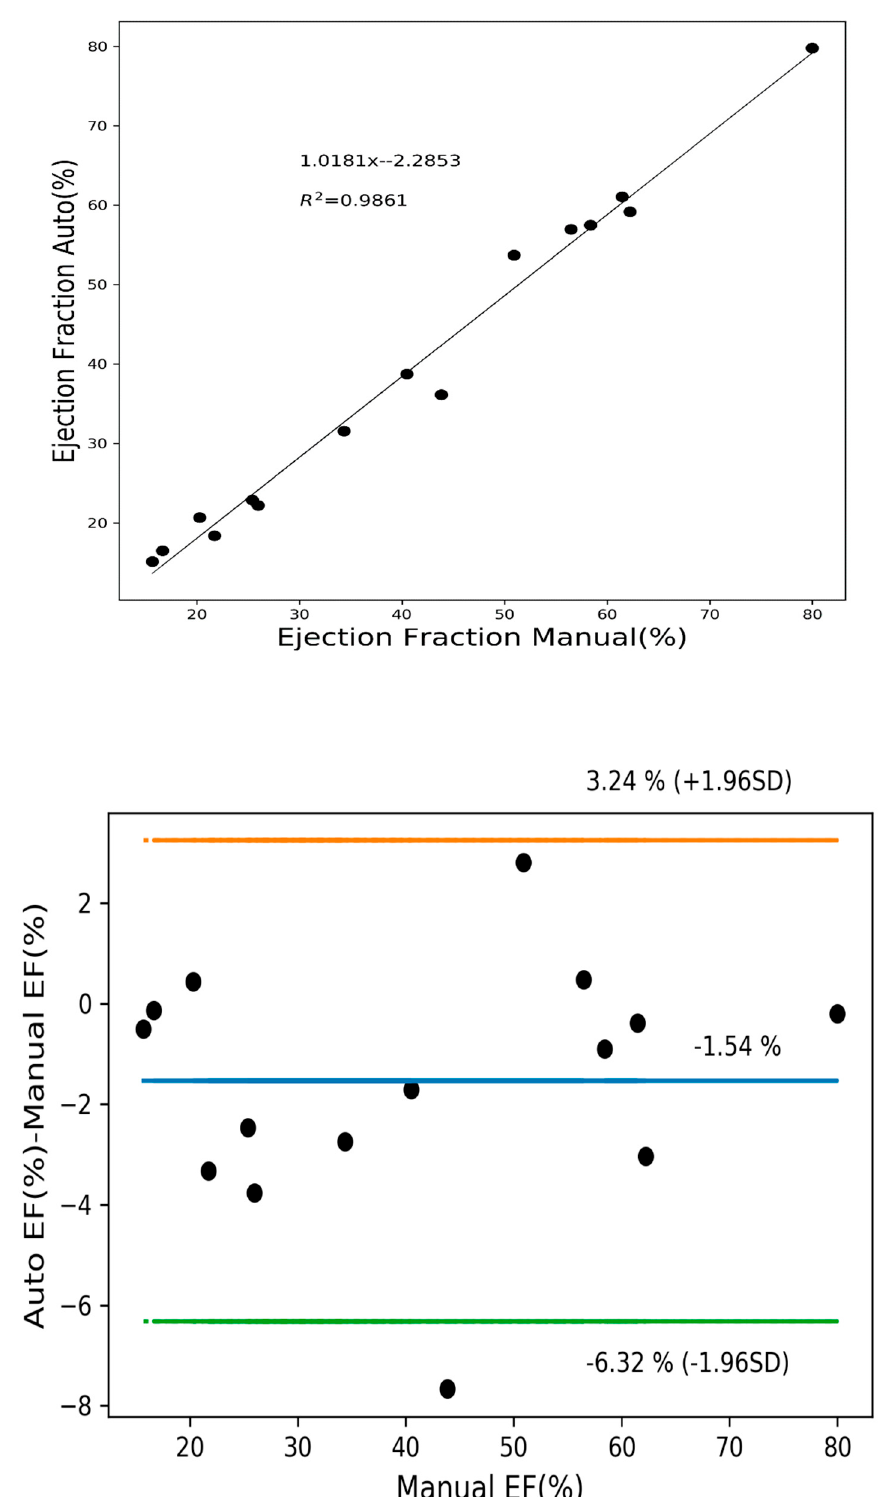
Figure 24. Linear regression plot (Top) and Bland-Altman plot (Bottom) for EF.